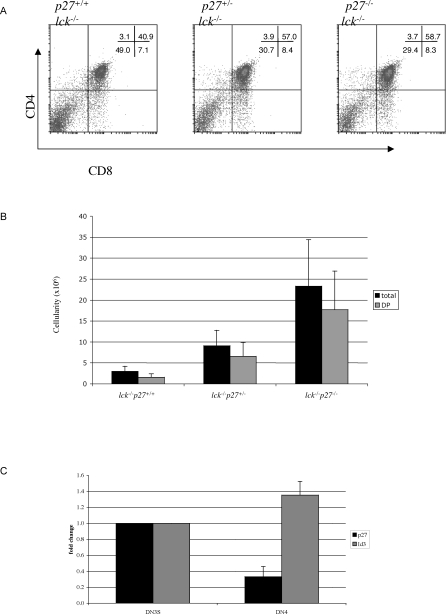
Loss of p27 Rescues the lck
−/− Phenotype(A) Representative FACS analysis of thymi from lck
−/−
p27+/+, lck
−/−
p27
+/−, and lck
−/−
p27
−/− mice indicating loss of one copy of the p27 gene rescues the lck
−/− phenotype.(B) The total cellularity for thymi and DP cells from all three genotypes are shown in the graph. Data were collected from three lck
−/−
p27+/+, seven lck
−/−
p27
+/−, and seven lck
−/−
p27
−/− mice.(C) Quantitative RT-PCR detected transcript levels for Id3 and p27 in wild-type small DN3 and DN4 cells. The fold change in the mRNA levels in the DN4 cells is relative to the DN3 cells.doi:10.1371/journal.pgen.0030219.g005